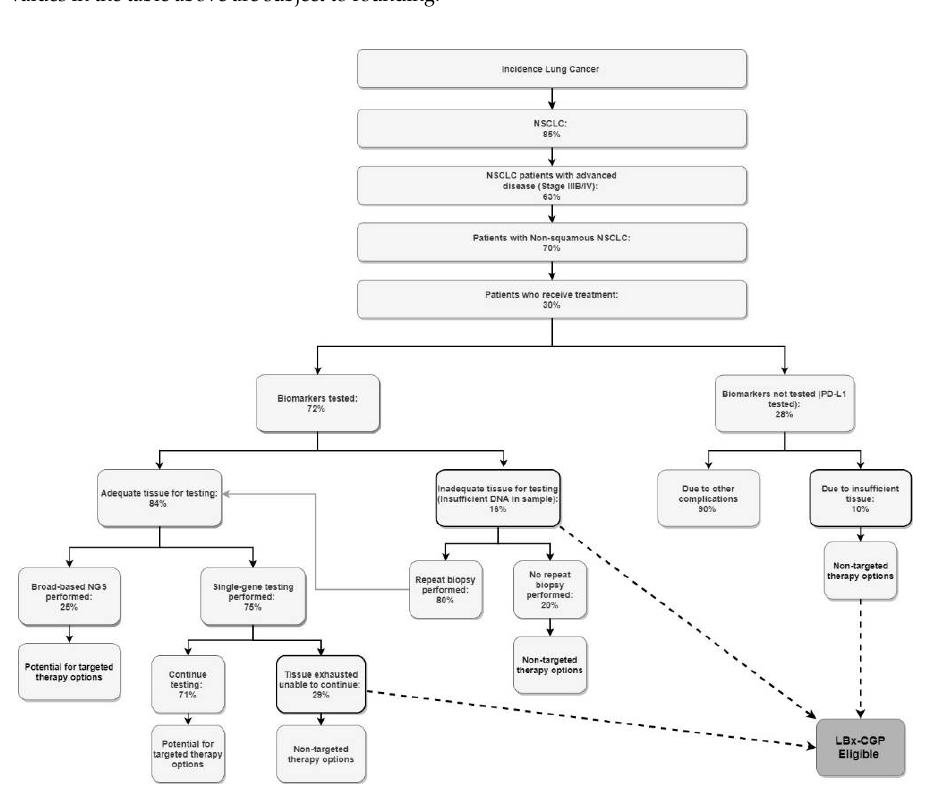
Figure 2. Market size estimation: patient testing journey.